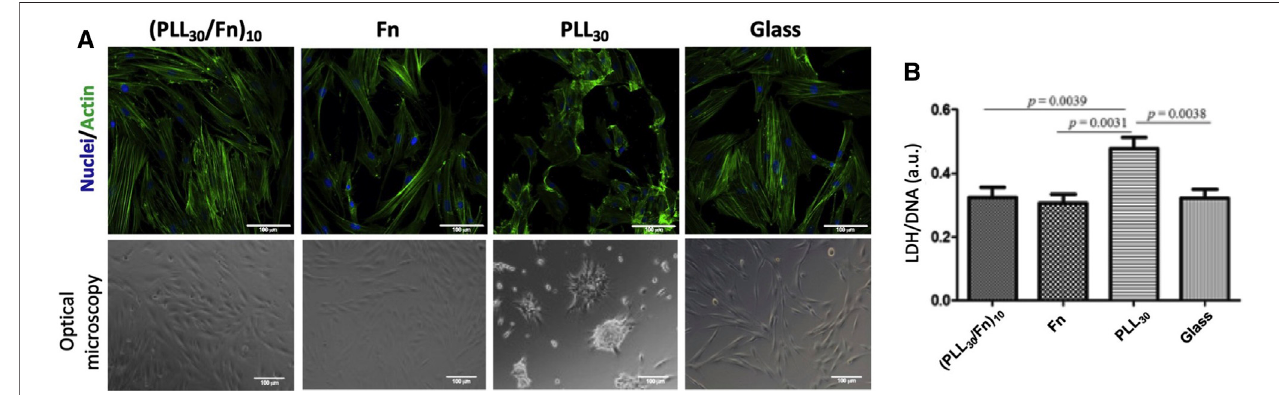
cytotoxic compared to positive control (glass). Statistically different at p < 0.05.